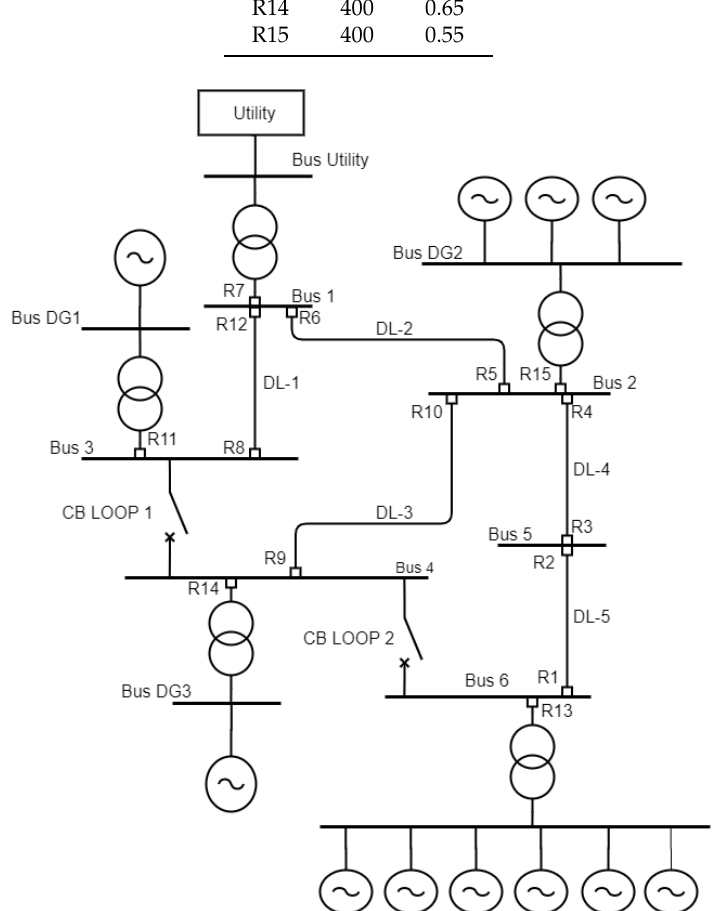
Figure 5. Benchmark IEC